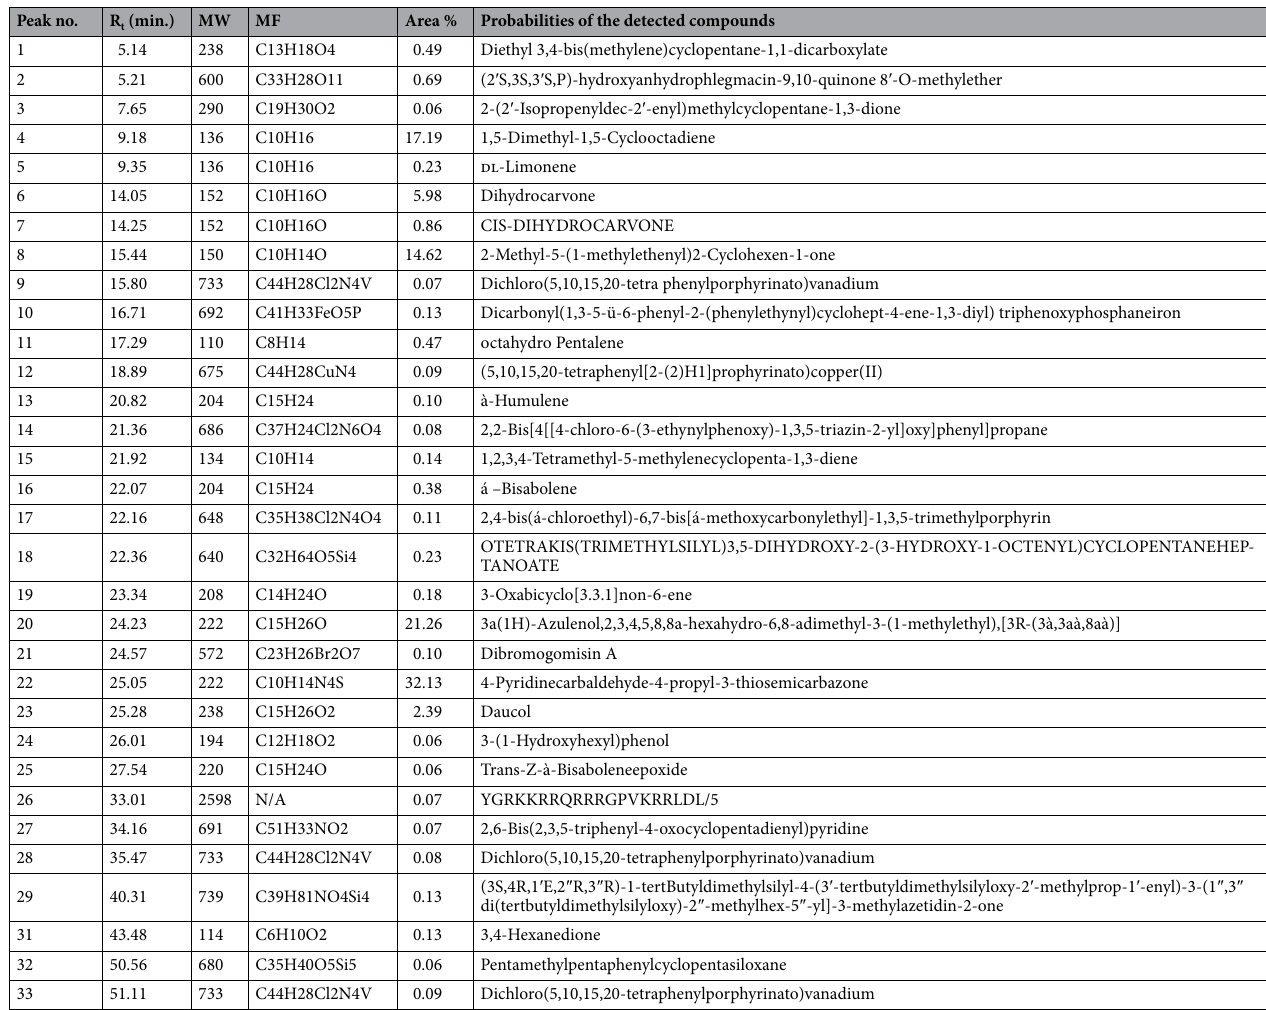
Table 8. GC/MS analysis of the Anethum graveolens